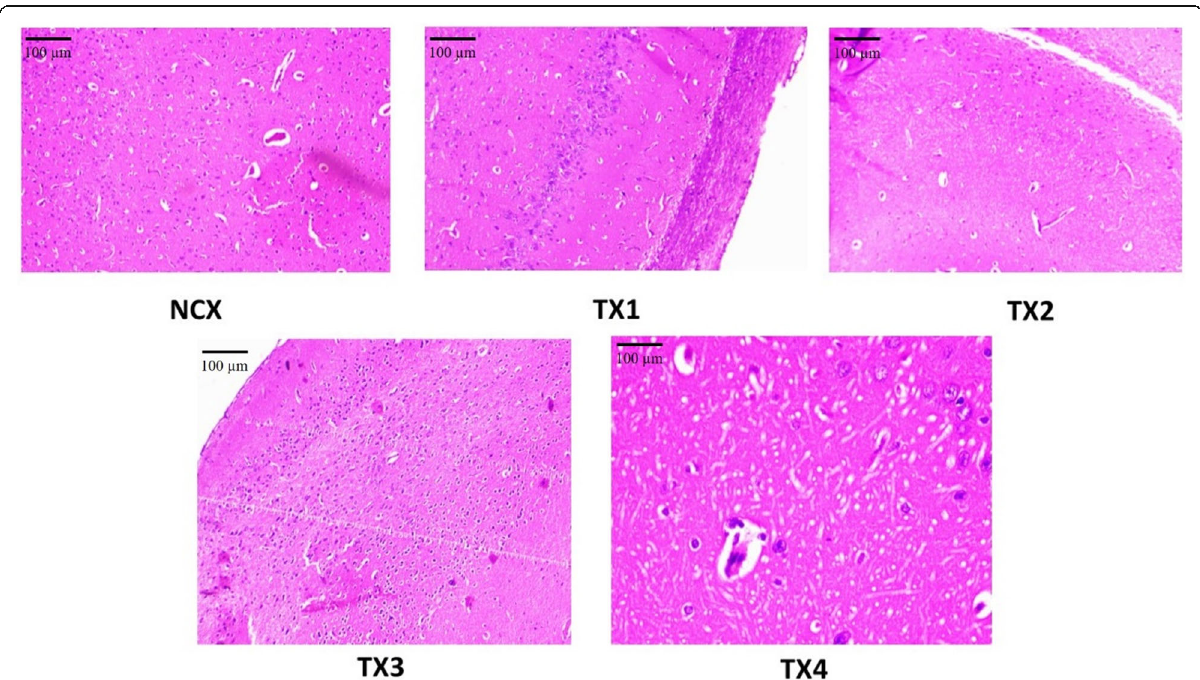
Fig. 8 The histopathology of brain from the different group of swiss albino mice (40 × magnification; Scalar bar: 100 μ m). No significant damage (ex. neuronal necrosis, neuronophagia, cellular necrosis, intact glial cells) was observed in the brain cells of any treated groups rats. The architecture of brain cells is normal in all experimental groups when compared to normal control group (NCX). Where NCX: Normal control group; TX1: Sub-acute toxicity group 1 (250 mg/kg/day/p.o); TX2: Sub-acute toxicity group 2 (500 mg/kg/day/p.o); TX3: Sub-acute toxicity group 3 (1000 mg/kg/day/p.o); TX4: Sub-acute toxicity group 4 (2000